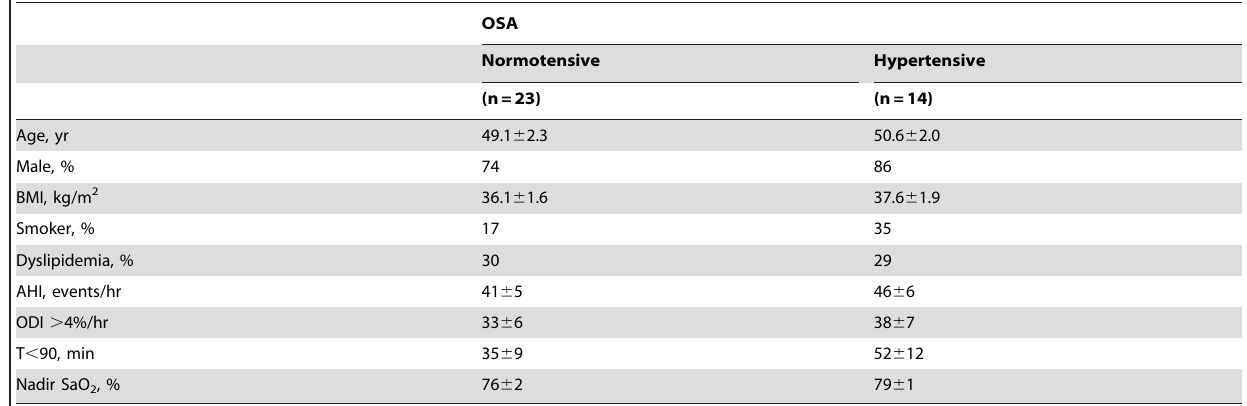
Table 1. Subjects’ characteristics.